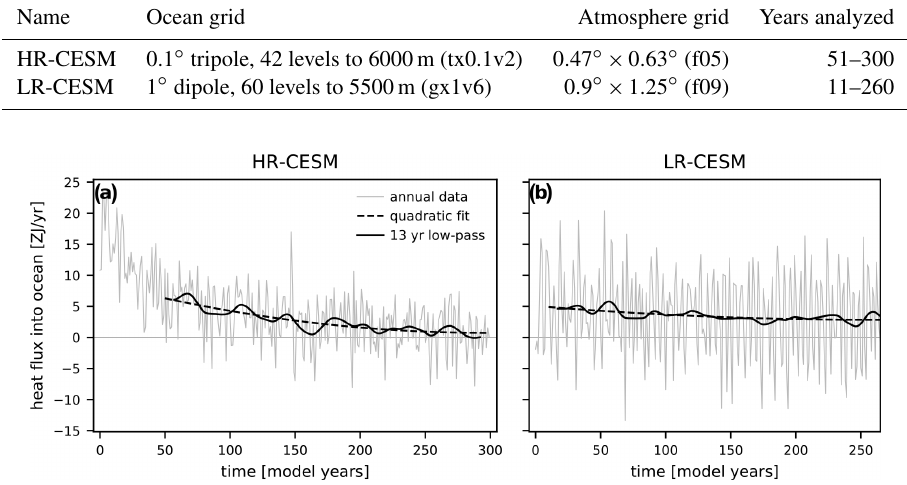
Figure 1. The globally averaged surface heat flux into the ocean of the HR- (a) and LR-CESM (b) simulations including the annual time series (thin line), the quadratic fit to the 250 analyzed model years (dashed line), and the 13-year low-pass-filtered version (solid line). For the low-pass-filtered time series, 7 years are removed at each end to avoid filter edge